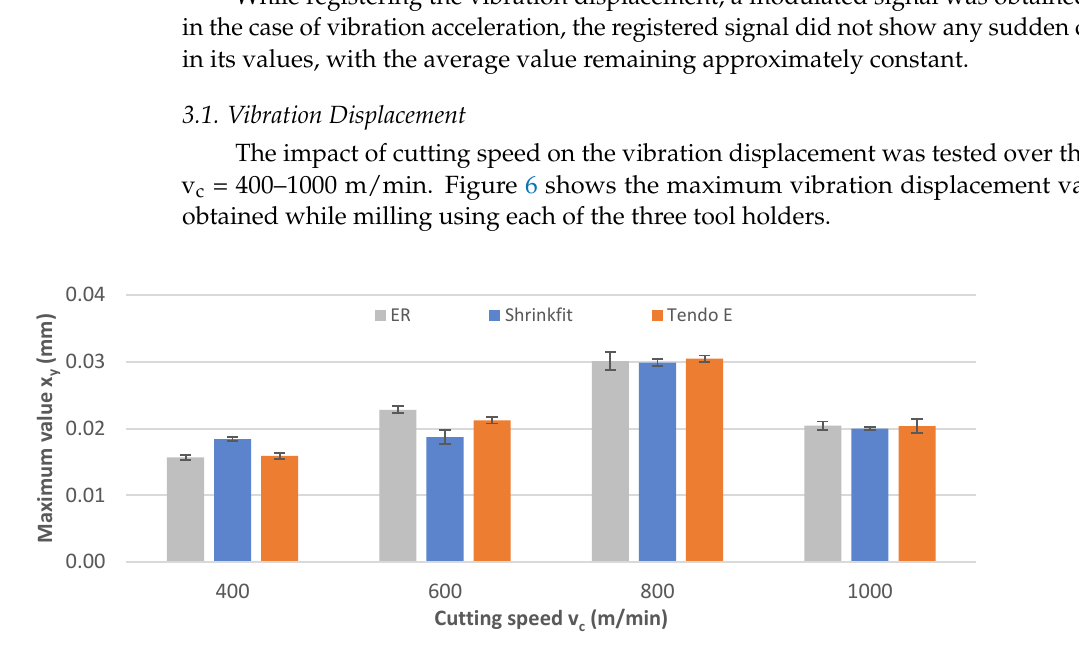
Figure 5. Examples of time series for ( a ) displacement, ( b ) acceleration of vibrations recorded during the milling process (v c = 800 m/min, f z = 0.05 mm/tooth, a p = 6 mm).